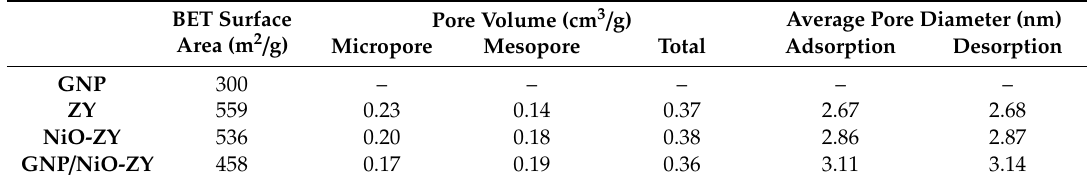
Table 1. Textural properties of the prepared catalysts and the as-received zeolite Y. BET Surface Pore Volume (cm 3 / g) Average Pore Diameter Area (m 2 / g)